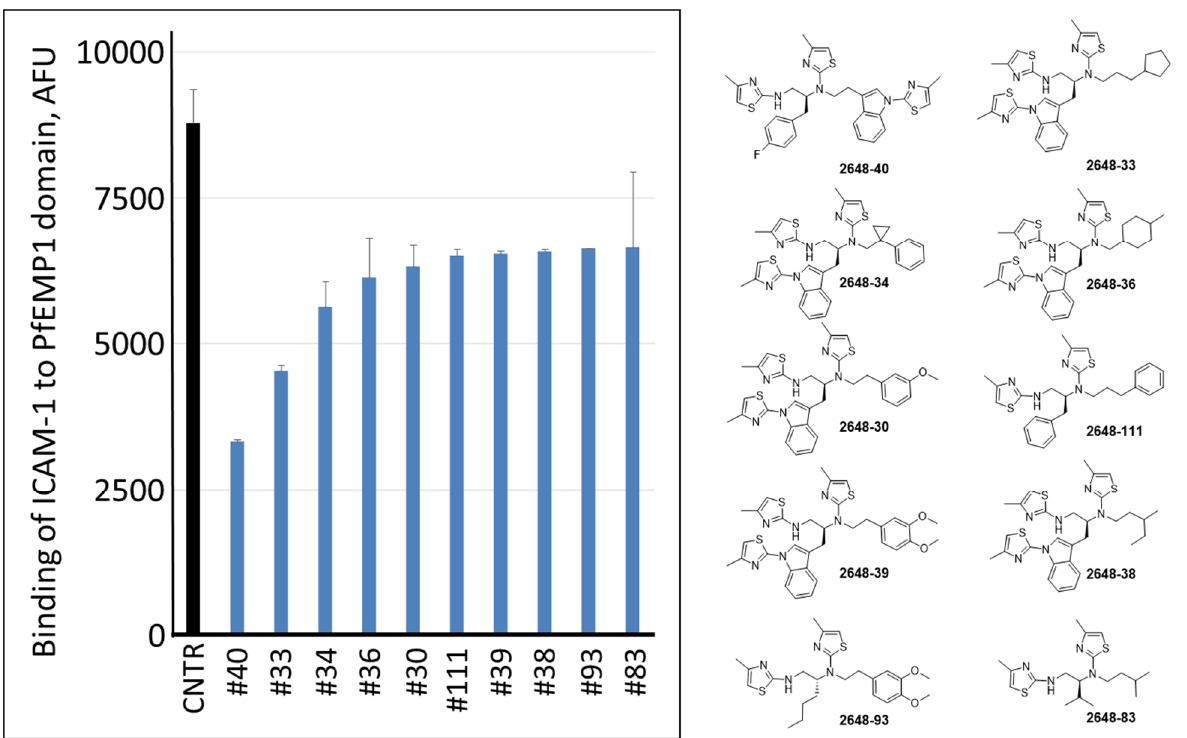
Figure 5. Binding of ICAM-1 to bead-immobilized ICAM-1-binding domain by ten best individual hits of TPI-2648 at 1 μM concentration. Bars represent averages and error bars are SD of two duplicate measurements. CNTR, no drug control. AFU, arbitrary fluorescence unites.